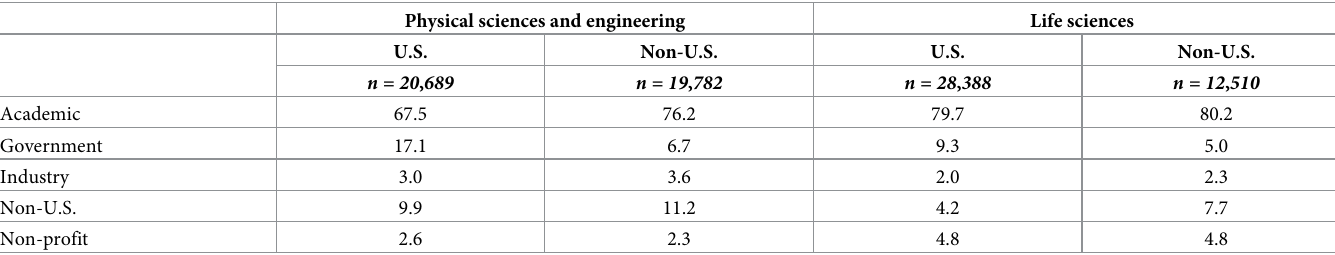
Table 5. Employment sector of postdocs (%) by citizenship status from 2009 to